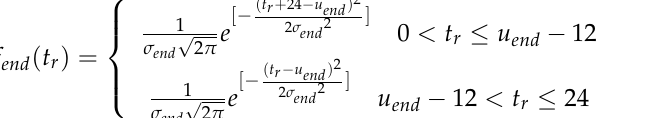
Table 1. The standard deviations and mathematical expectations of users’ return time in different seasons. Parameters Spring Summer Autumn